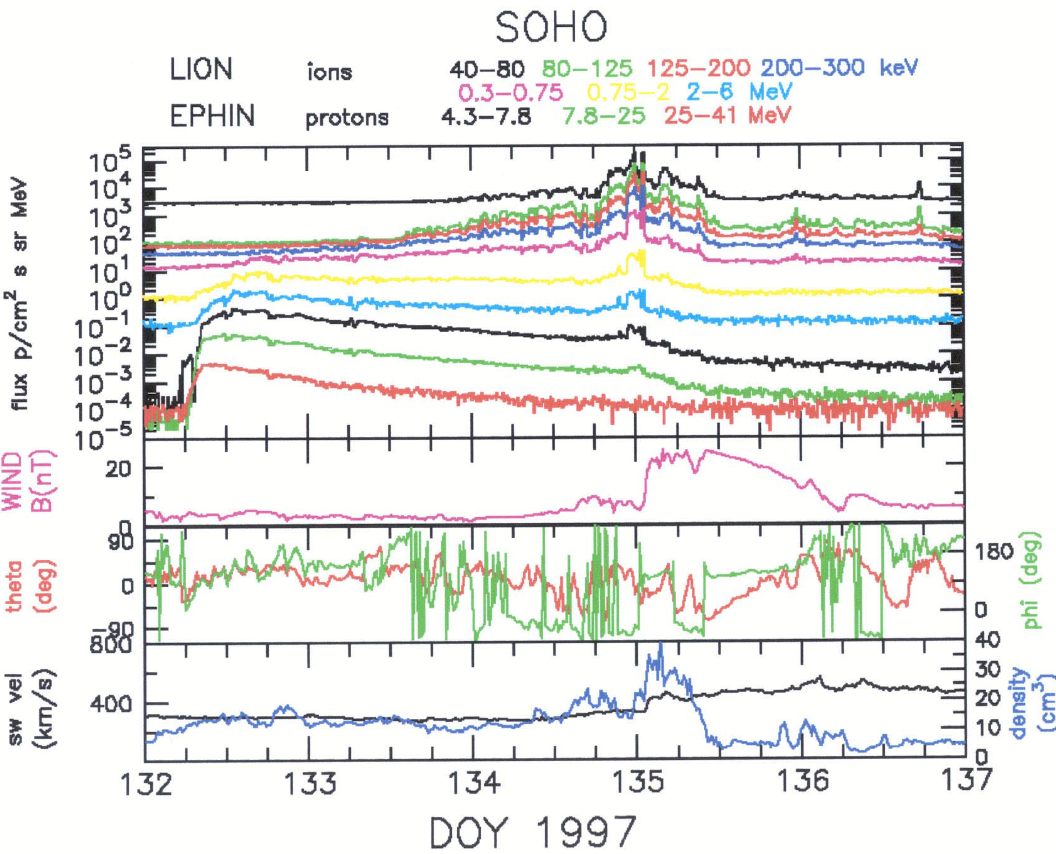
Fig. 2. Top Panel: Energetic particle data recorded by the LION and EPHIN instruments on SOHO during Event 1 (initiated on 12 May 1997). Various energy ranges are indicated by individual colors. The lower three panels present contemporaneous values of the total IMF; polar angles of the IMF and solar wind speed and density measured aboard